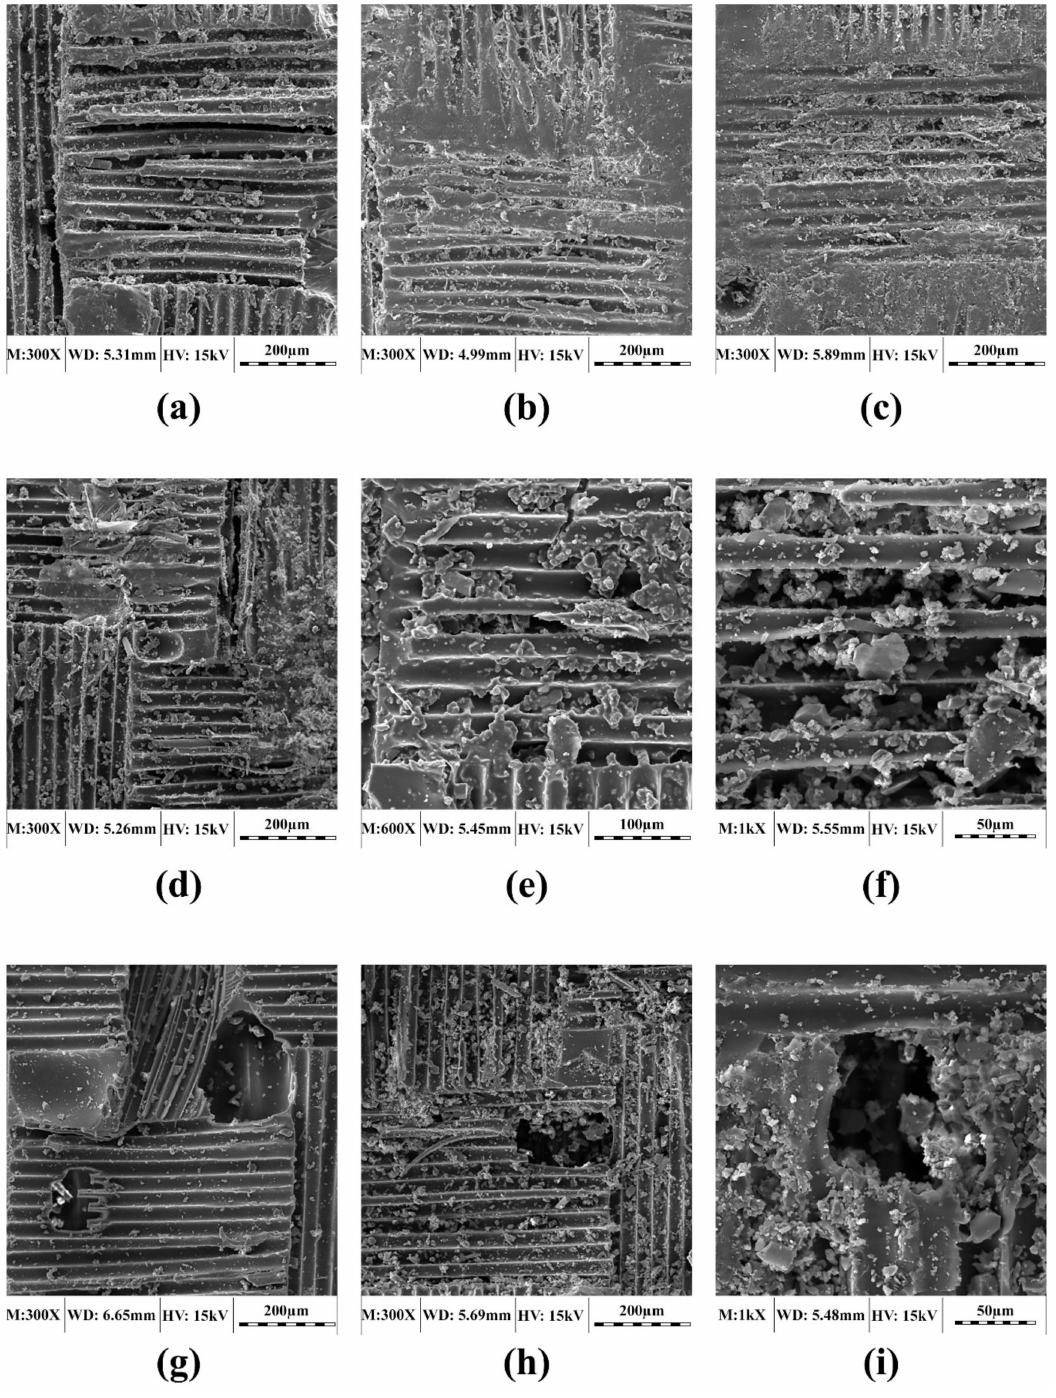
Figure 6. SEM micrographs of selected 2-mm laminates exposed to wet freeze / thaw cycles: ( a ) UL exposed to 750-h cycles, ( b ) UL exposed to 1250-h cycles, ( c ) UL exposed to 2000-h cycles, ( d ) WL exposed to 750-h cycles, ( e ) WL exposed to 1250-h cycles, ( f ) WL exposed to 2000-h cycles, ( g ) RL exposed to 750-h cycles, ( h ) RL exposed to 1250-h cycles and ( i ) RL exposed to 2000-h